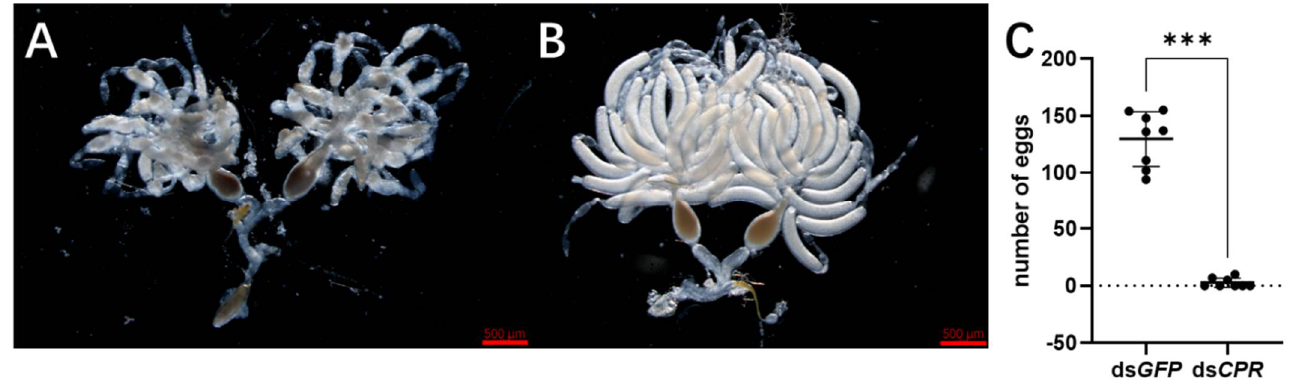
Figure 4. Phenotypes of RNAi. Each dsRNA was injected in the 5th-instar nymphs at 48 h after hatching. Ovaries of female adults were observed in ds CPR - ( A ) and ds GFP -injected insects ( B ). ( C ) Oviposition analysis. A dsRNA-injected female was mated with a non-injected male in each replicate and oviposition for 10 days. The eggs in the rice leaf sheaths were dissected and counted. Biological replicates were carried out for each mating (n = 8 ♀ × ♂ ). The statistical significance of the number of the laid eggs between the different treated groups was tested by a Student’s t -test. The asterisk ∗∗∗ indicate significant differences at p < 0.001.